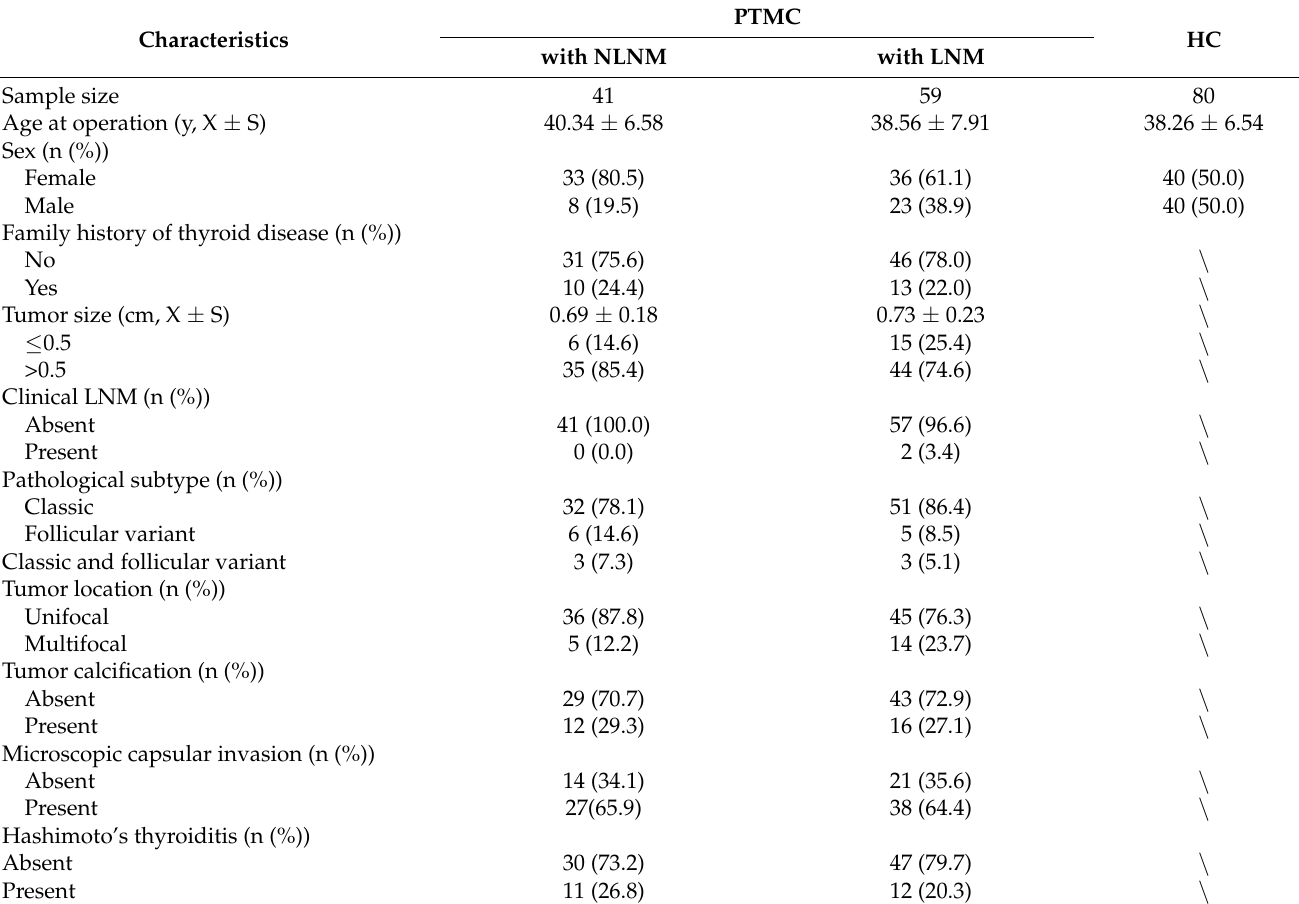
Table 1. Clinical and pathological